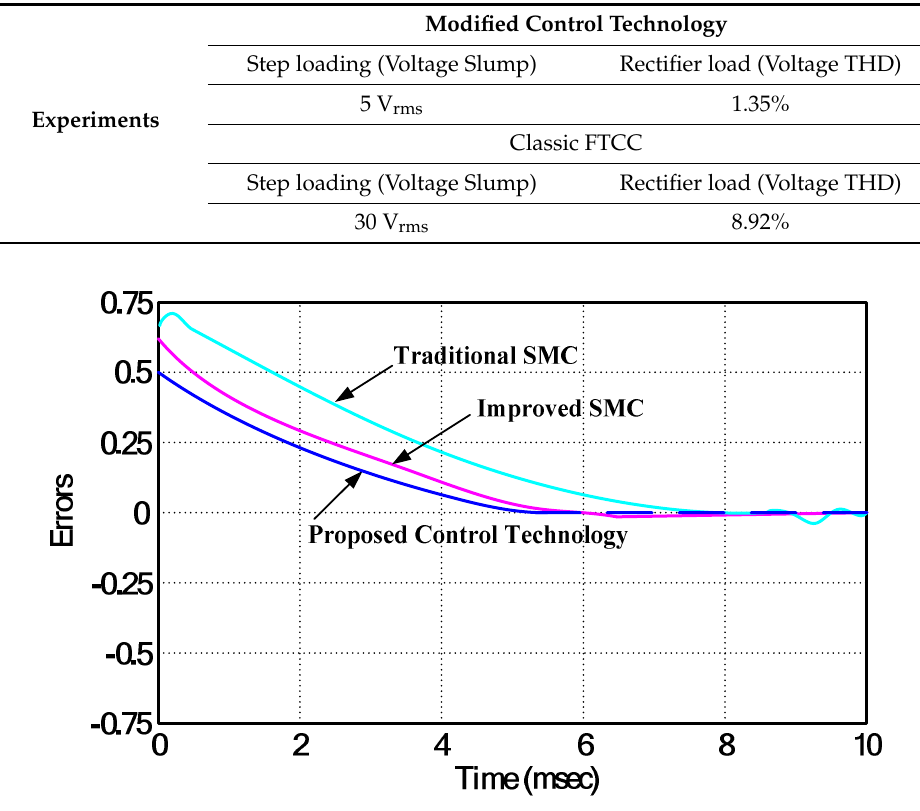
Figure 15. A comparison of tracking errors. SMC—sliding mode control.